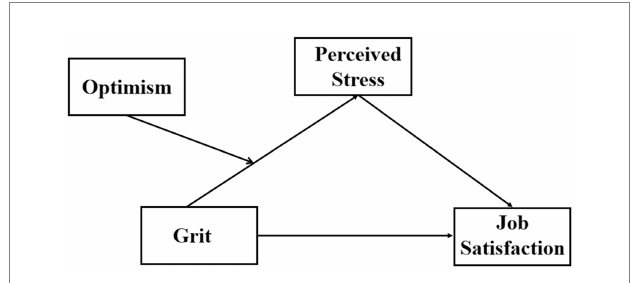
FIGURE 1 The hypothesized moderated mediation model.